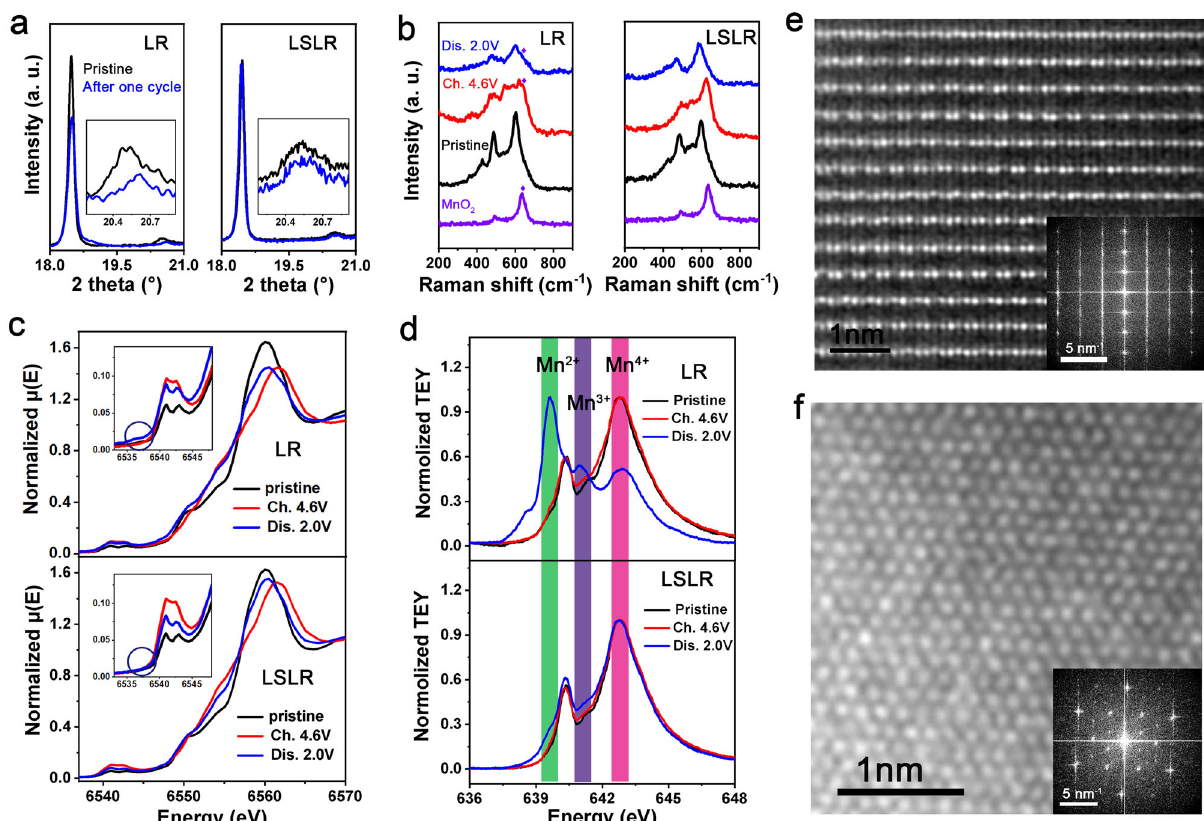
Fig. 3 Mitigated cation migration in LSLR. a The XRD plots for pristine and one-cycled electrodes. The insets show the superlattice peaks. b Ex situ Raman results of the electrodes at different states of charge. The purple rhombus is used to label the Raman peak of MnO 2 c , d Mn K-edge ( c ) and L 2 -edge spectra ( d ) for electrodes at different states of charge. The insets declare the pre-edge of normalized XAS spectra at Mn K-edge. Ch. and Dis. are short for charge and discharge. e , f AC-STEM and FFT images along [100] ( e ) and [103] ( f ) axis for 4.6-V charged LSLR. Source data are provided as a Source Data fi